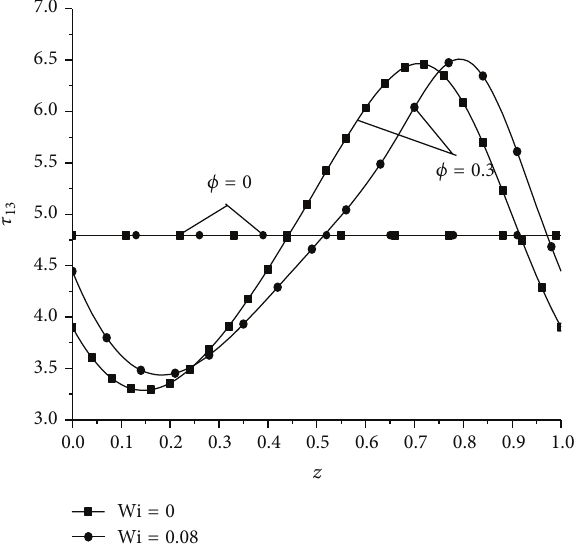
Figure 12: The variation of pressure rise over the length Δ𝑝 with 𝑄 for different values of 𝜙 and 𝜖 at Wi = 0.01 , Re = 10 , and 𝛿 = 0.08 .